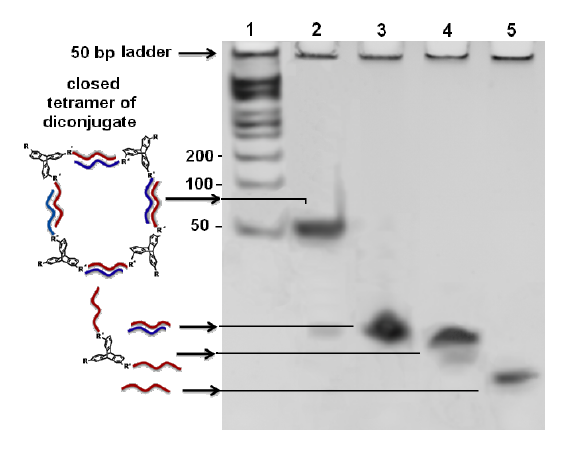
Figure 3: Native PAGE-gel image (8%) of self-assembled triconju- gated DNA–TPA units with 2 μ M total ssDNA concentration. Lane 5 shows the self-assembly of triconjugates in the presence of Zn PpIX.